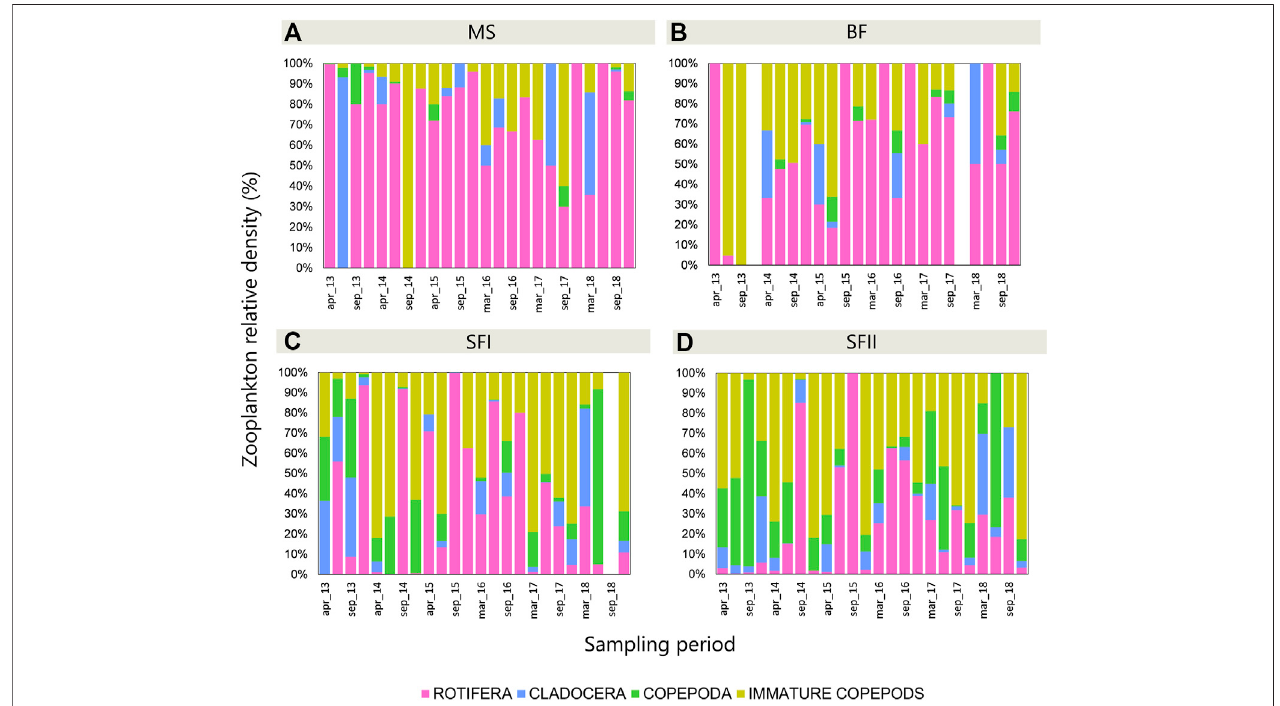
FIGURE3| Zooplanktonrelativedensity(%)inthethreeSmallHydroelectricPowerPlant(SHP)reservoirs: (A) MonteSerrat(MS; n =24), (B) Bonfante(BF; n =24), (C) Santa Fé I (SF I; n = 24) and (D) Santa Fé II (SF II; n = 24) sampled from 2013 to 2018.